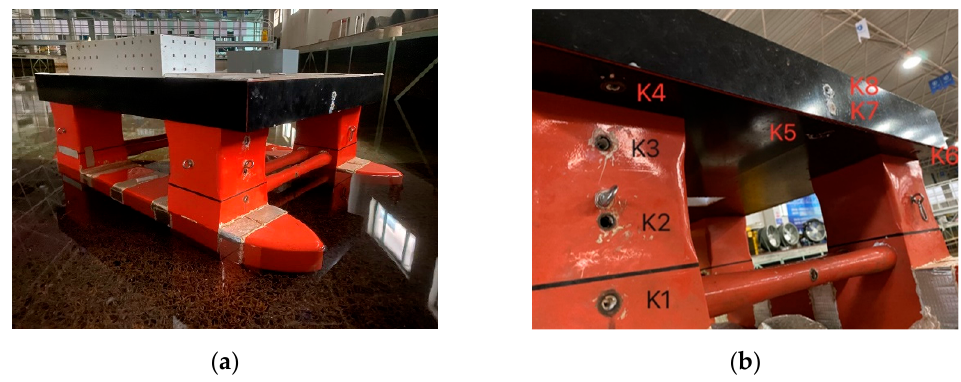
Figure 4. ( a ) The overall appearance of the test model. ( b ) The location of the monitoring points. Table 2. Working conditions of the regular wave.